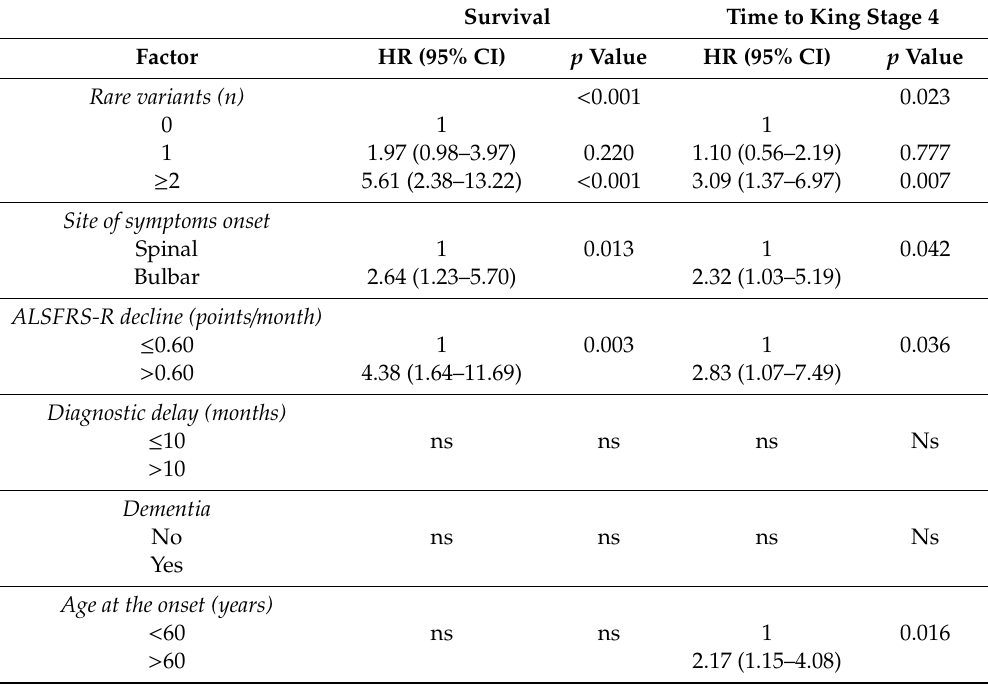
Table 3. Cox proportional hazards regression multivariate analysis on survival and time to reach King stage 4 (MAF <